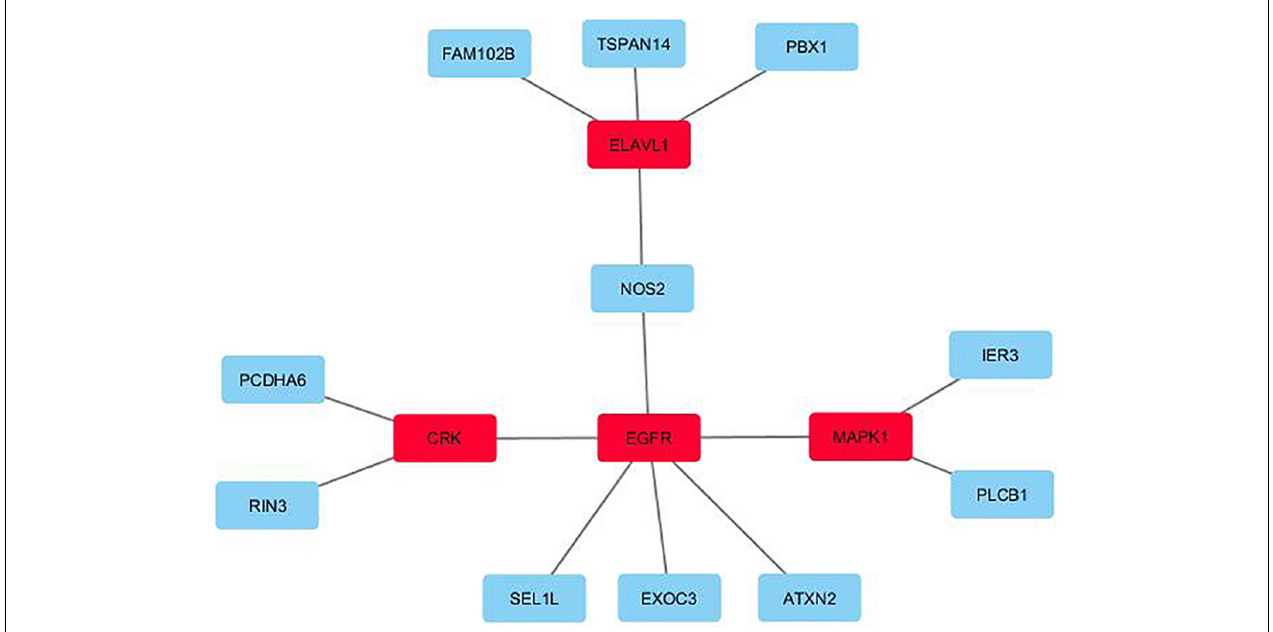
FIGURE 1 | The key network identified by the unsupervised de novo pathway enrichment analysis for the 25-gene overlap. The exception nodes are highlighted in red, while the genes from the 25-gene overlap are highlighted in